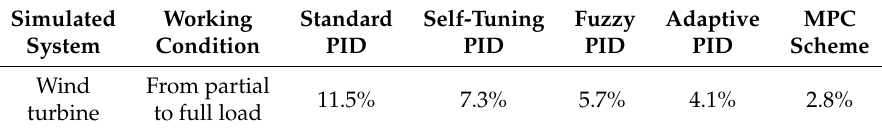
Table 1. Performance of the considered control solutions for the wind turbine. Simulated Working Standard